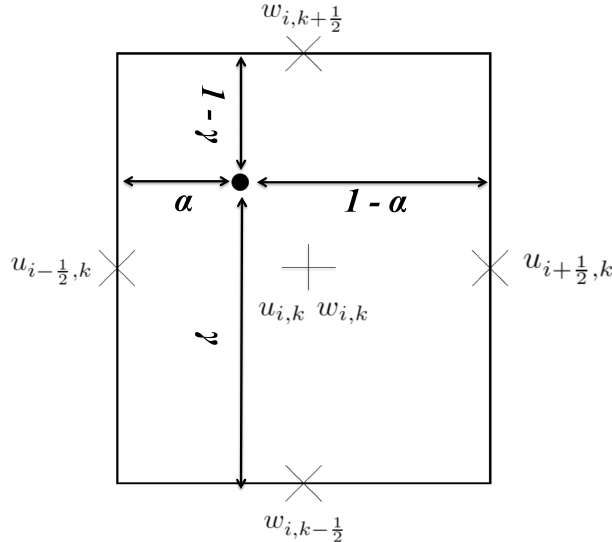
Figure 3. Illustration of the interpolation scheme used in the super- droplet transport scheme referred to as “simple” in the text. The rectangular box represents a single grid cell with u and w depicting horizontal and vertical velocities perpendicular to grid cell bound- aries used in the advection scheme of the Eulerian model. The large dot represents droplet